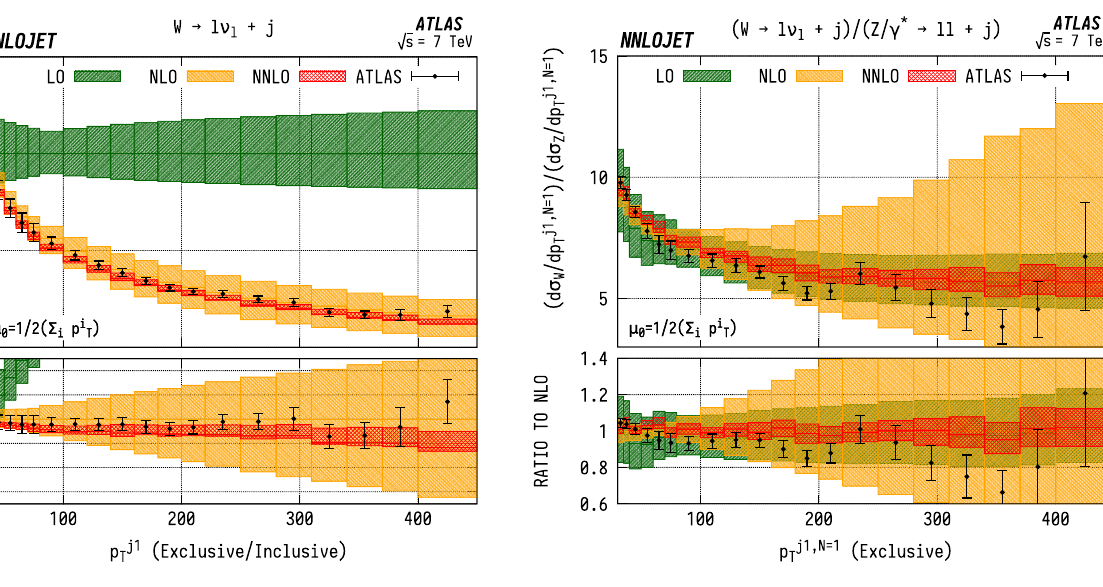
Fig. 18 Ratio of exclusive/inclusive ( N = 1 / N ≥ 1 ) WJ production differential in the transverse momentum p T of the leading jet. Errors on the ATLAS data are approximated using uncertainties from the N = 1 distribution normalised to the N ≥ 1 results. See Fig. 14 for details